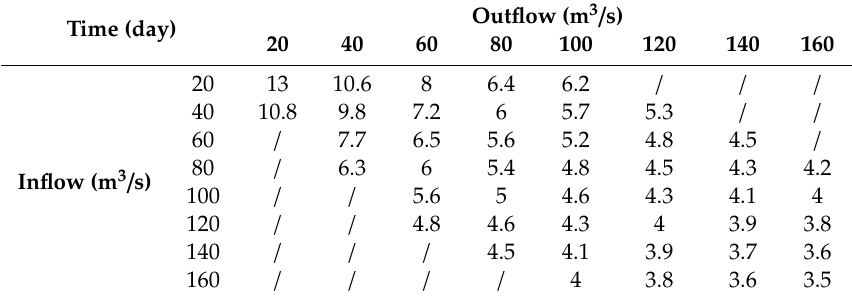
Table 2. The time taken to reach suitable ecological water temperature under di ff erent inflow and outflow scenarios. Time (day)